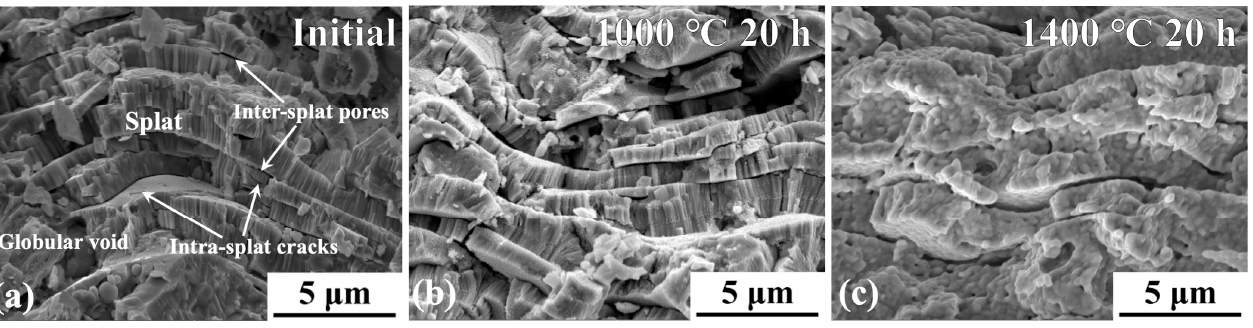
Figure 3. Evolution of the microstructure of APS YSZ coatings under thermal exposure: ( a ) as-de- posited; after thermal exposure at ( b ) 1000 °C and ( c ) 1400 °C (SEM HV:15.0 kV, WD:6.65 mm, MAG: deposited; after thermal exposure at ( b ) 1000 ◦ C and ( c ) 1400 ◦ C (SEM HV:15.0 kV, WD:6.65 mm, 10.0 kx). MAG: 10.0